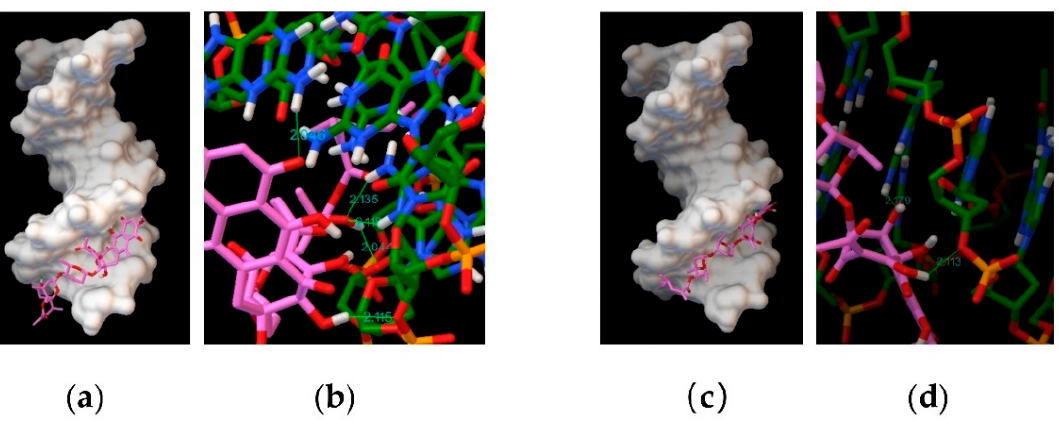
Figure 8. Computational docking model DNA (PDB ID 1BNA): ( a ) binding mode of dutomycin to DNA (PDB ID 1BNA); ( b ) hydrogen bond position and distance between dutomycin and DNA (PDB ID 1BNA); ( c ) binding mode of SW91 to DNA (PDB ID 1BNA); ( d ) hydrogen bond position and distance between SW91 and DNA (PDB ID 1BNA). Table 4. Hydrogen bond interactions for compounds dutomycin and